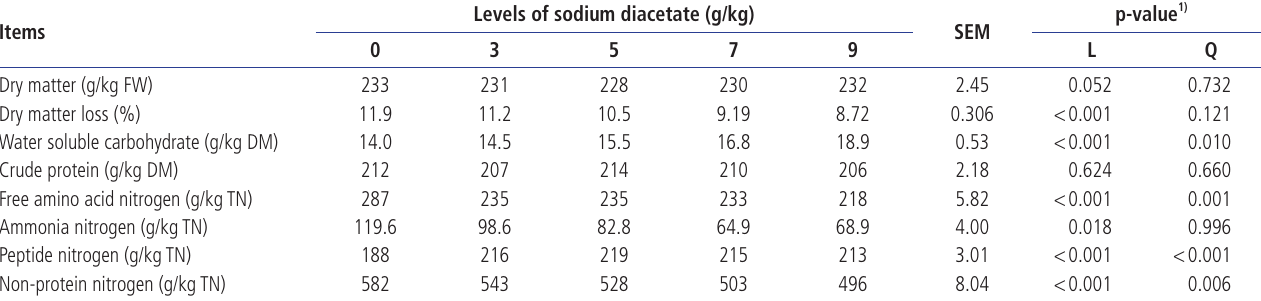
Table 3. Chemical composition and nitrogen fractions of alfalfa ensiled with different levels of sodium diacetate Items